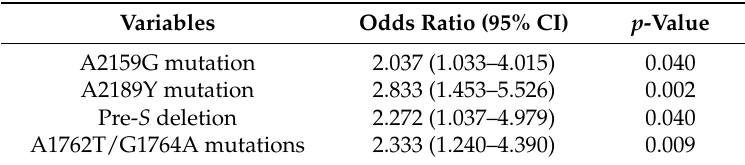
Table 4. Multivariate analysis of independent factors for the risk of